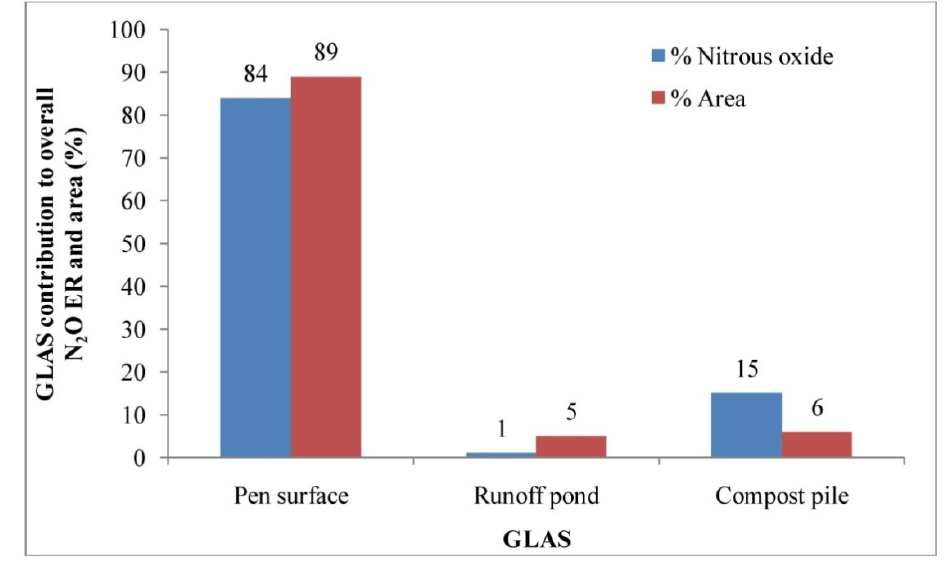
O ER and area at the feedyard. 2